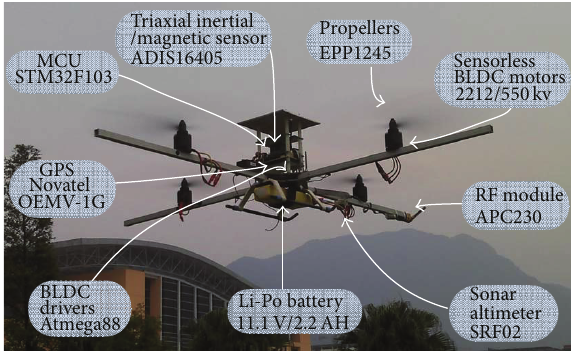
Figure 11: The home-made prototype